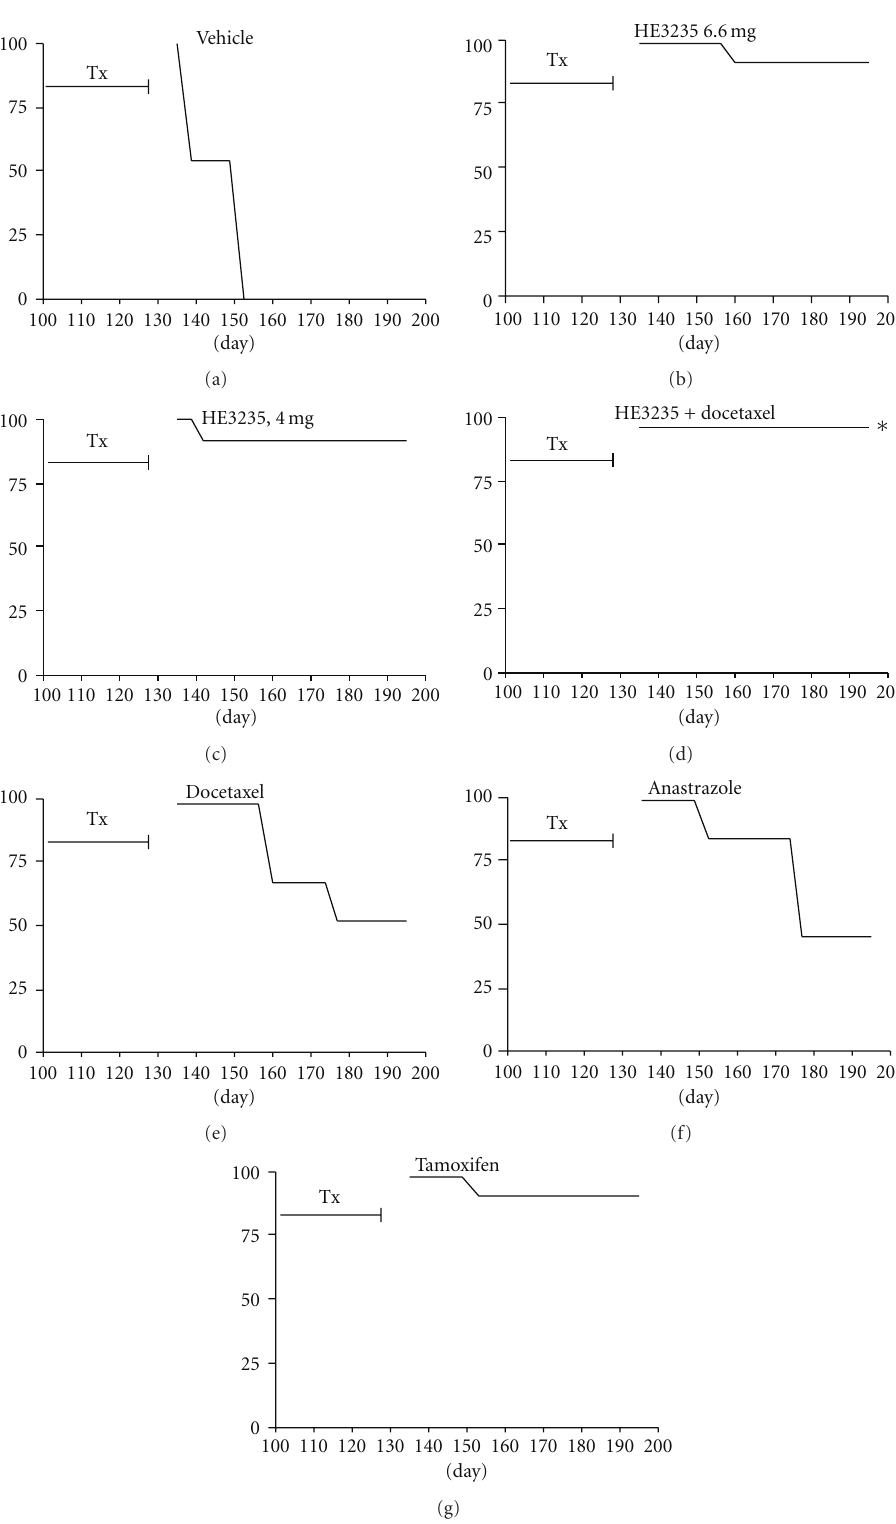
Figure 1: % Survival. Seven-week-old female Lewis rats were treated with a single IP injection of 50mg/kg MNU. Tumors developed for 90 days, prior to treatment ( n = 13) for 28 days with (a) cyclodextrin vehicle daily, (b) 6.6 mg HE3235 daily, (c) 4mg HE3235 daily, (d) 6.6mg HE3235 daily + 1.5mg docetaxel weekly, (e) 1.5 mg docetaxel weekly, (f) 2.5mg anastrazole daily, and (g) 0.25mg tamoxifen weekly. HE3235 in combination with docetaxel was more e ff ective than comparator monotherapies at promoting survival. Y -axis, percent survival; X -axis, study day. Therapy (Tx) started on Day 101 and ended on Day 128. The first animal was sacrificed on day 139 (vehicle group). ∗ P = . 0149 versus docetaxel on day